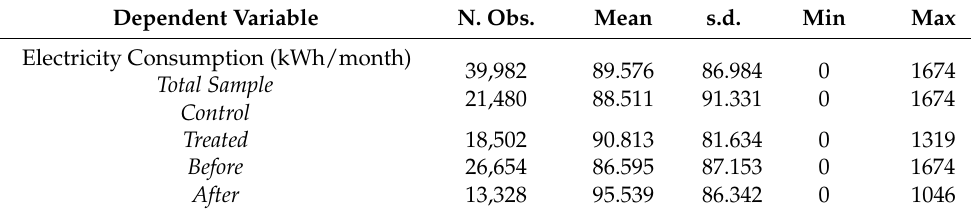
Table 1. Summary